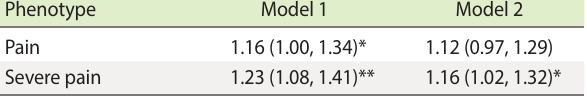
Model 1: Adjusted for sex, age, chronic disease (hypertension,